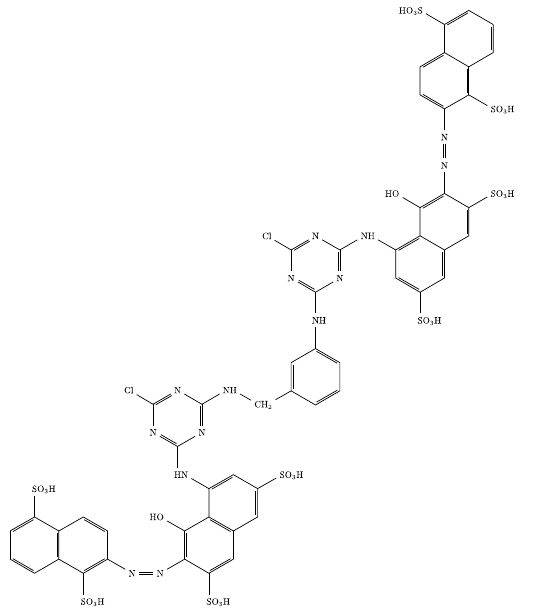
Figure 9. Chemical structure CAS No. 17095-24-8.